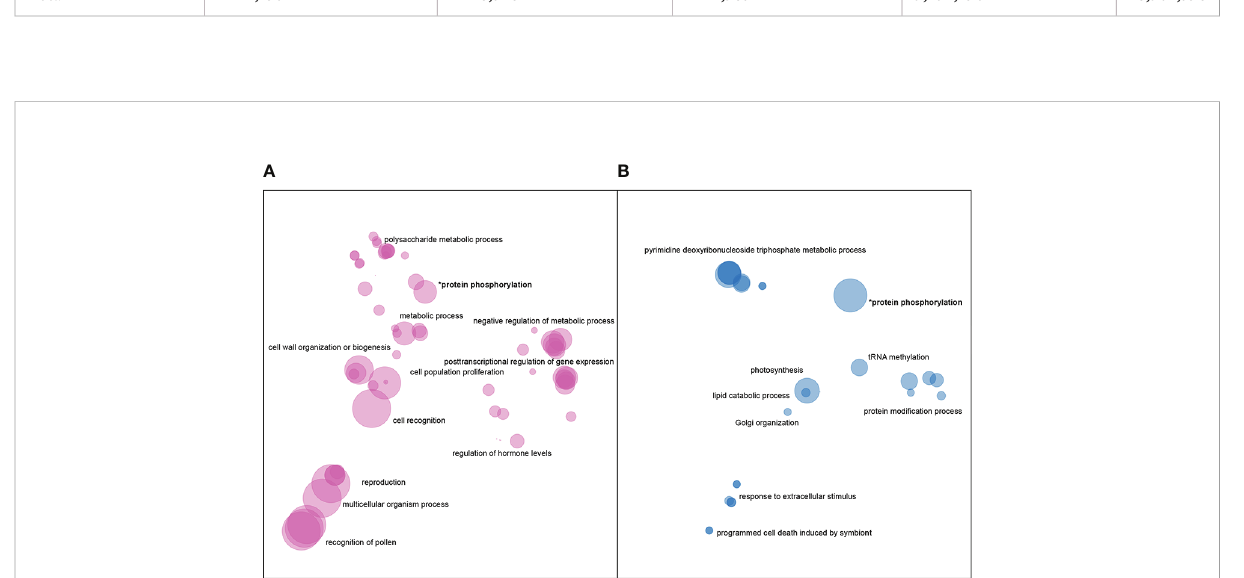
FIGURE 4 Enriched GO terms for genes impacted by (A) nonsynonymous SNPs and (B) large SVs. GO terms in each dataset were clustered and plotted based on semantic similarity as described in the Materials and Methods. Circle size is proportional to p-value, with larger circles indicating more signi fi cant